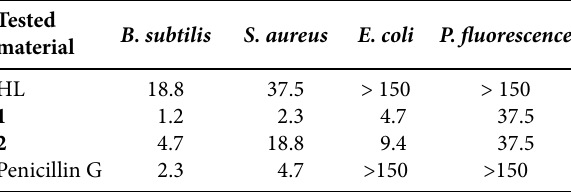
Table 4. Antimicrobial activities of the